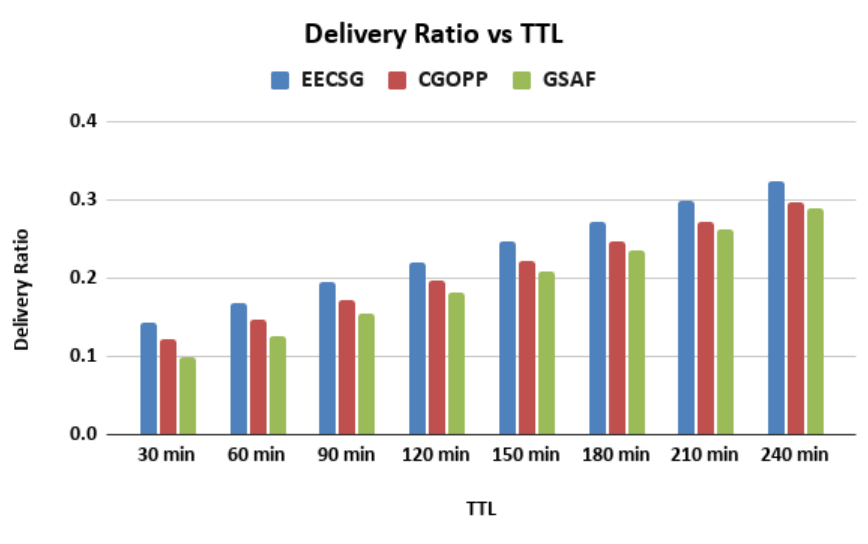
Figure 8. Delivery ratio vs. Time-to-Live (TTL).